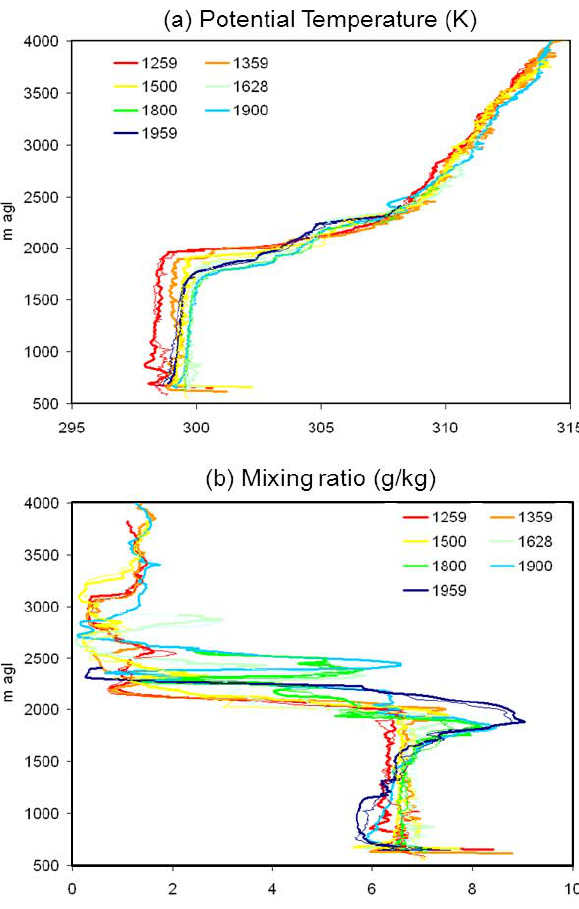
Fig. 6. Time series of hourly soundings performed on 1 July 2011 between 13:00 and 20:00UTC. (a) Potential temperature (K) and (b) water vapour mixing ratio (gkg − 1 ). Bold and thin lines corre- spond to ascending and descending soundings,